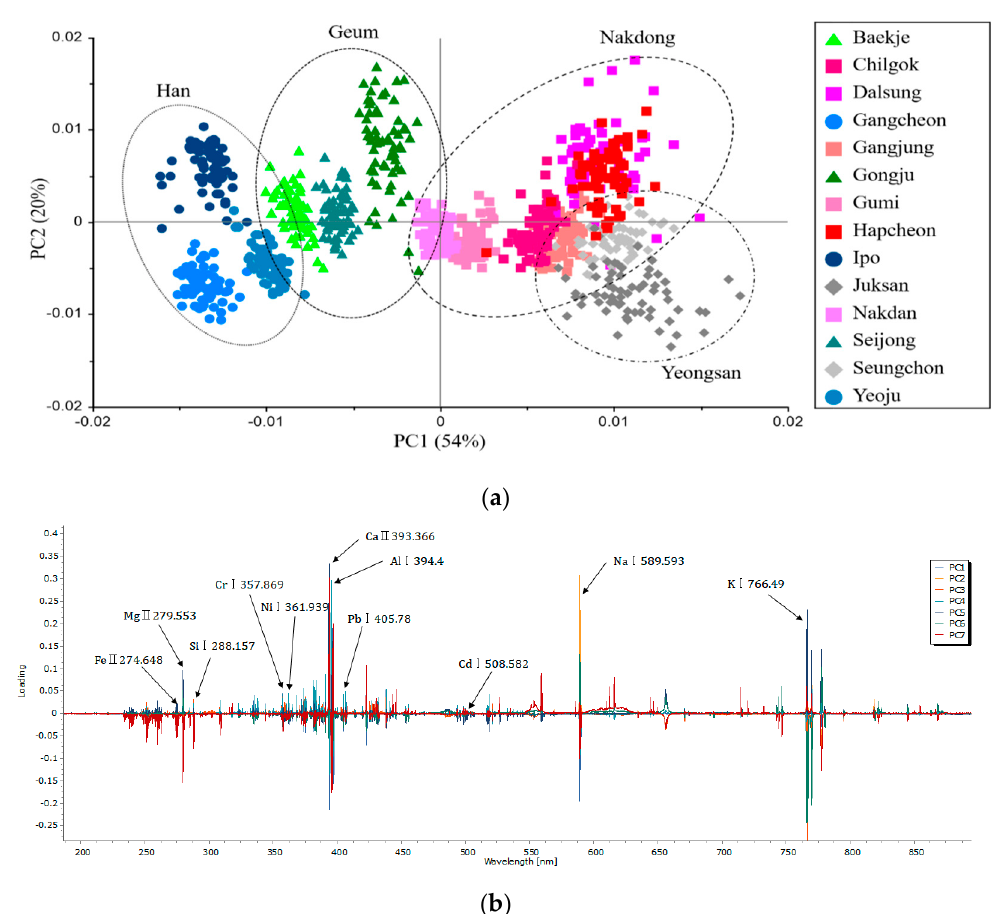
Figure 4. Score plot of the first two PCs ( a ) and loading plot of the seven PCs ( b ); the plots of the seven PCs from the PCA use the full spectra of the sediment samples.